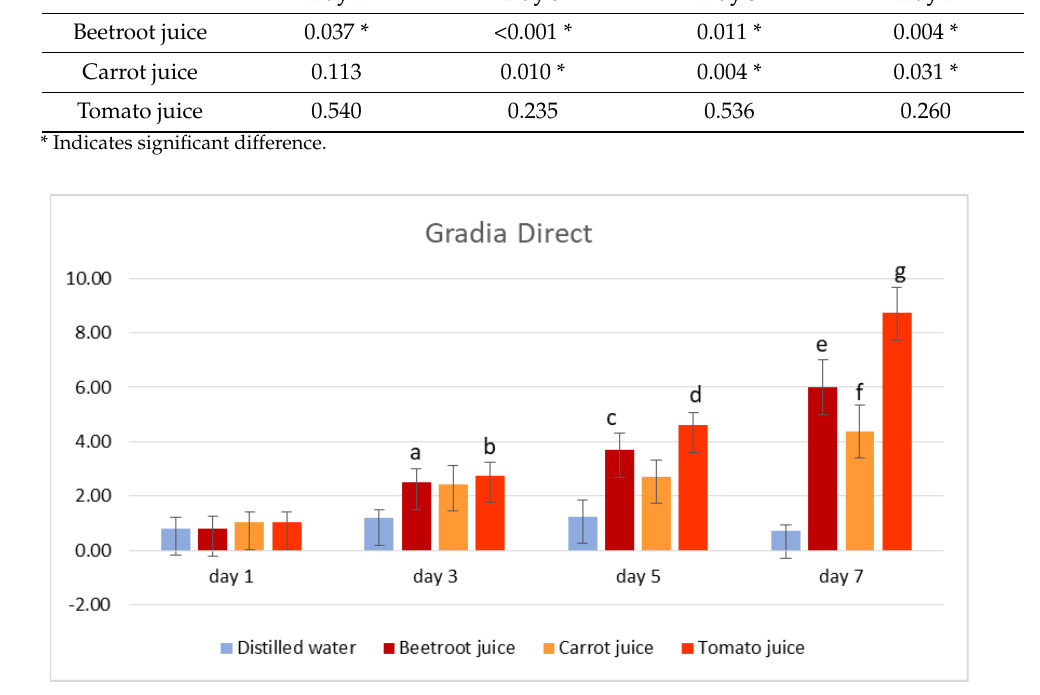
Table 1. p -values for independent t -test (for comparison of ∆ E * for both materials at different time points).